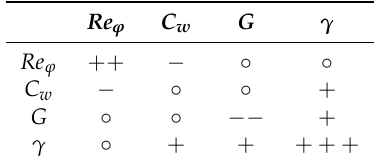
Table 3. Summary of the observed main effects (major diagonal) and interactions (minor diagonals) for increasing the variable parameters from the lowest to the highest factor